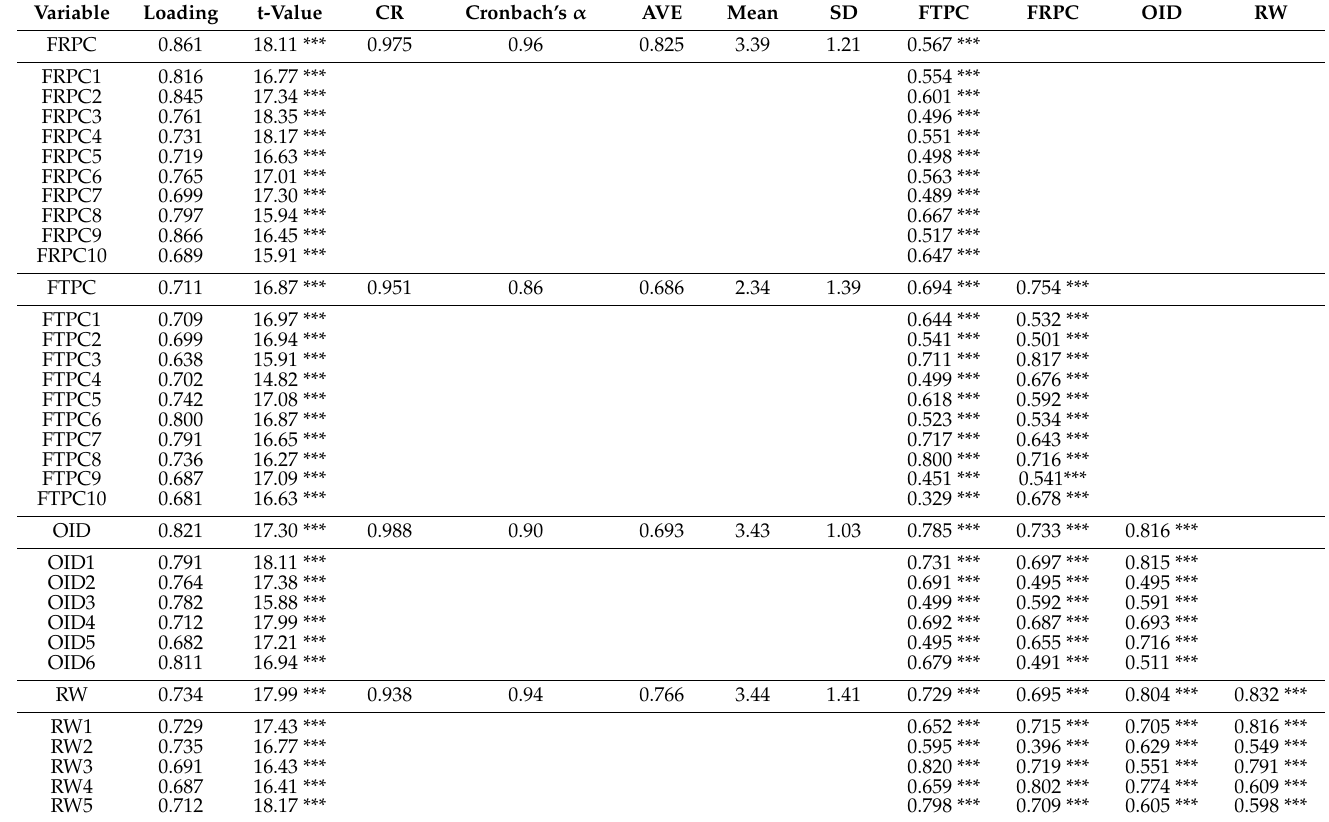
Table 3. Results Convergence accuracy of the measurement model and the mean (M), standard deviation (SD), correlation